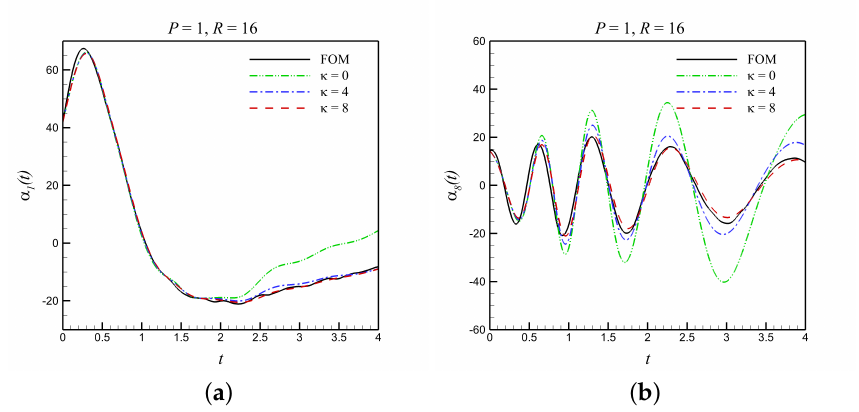
Figure 9. Temporal evolution of the first ( a ) and eighth ( b ) modal coefficients in the presence of closure